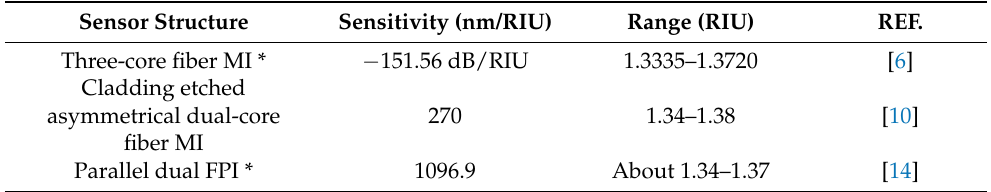
Table 4. Comparison of the MCF interferometer-based refractive index